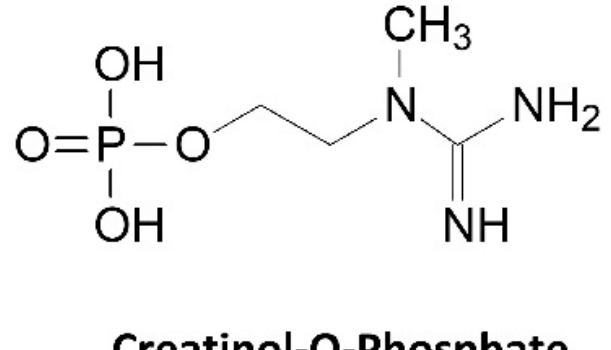
Figure 17. Chemical structure of Creatinol-O-Phosphate.